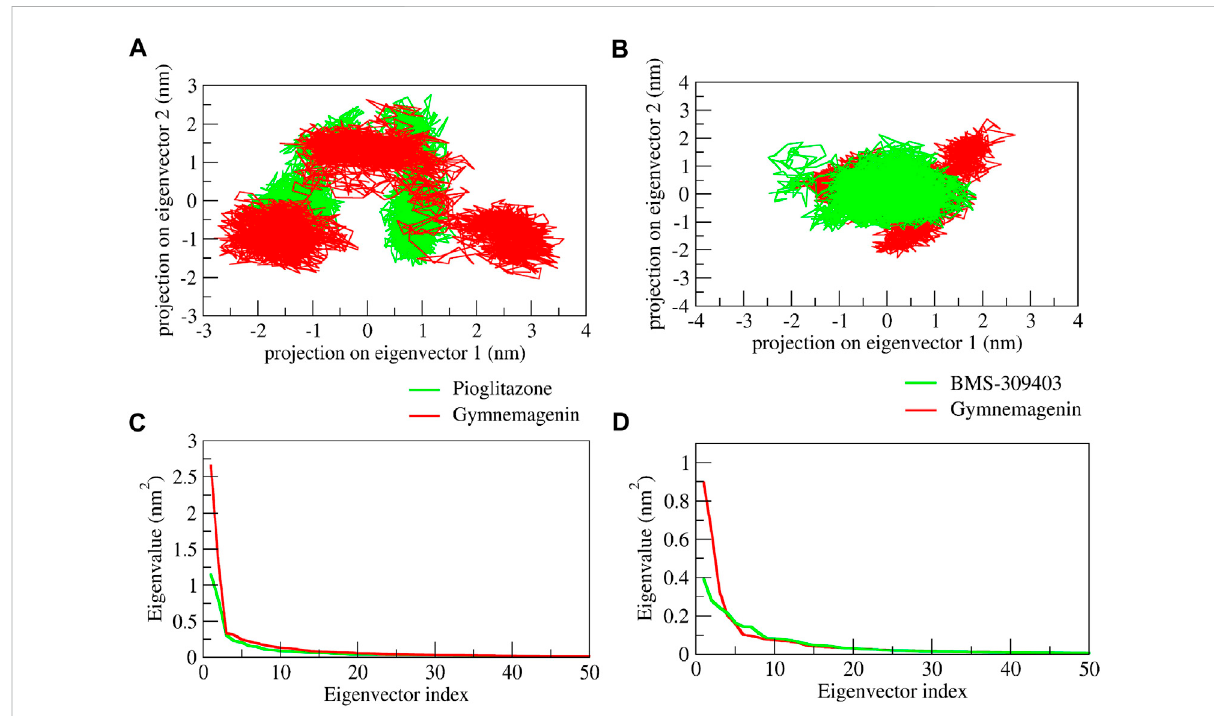
FIGURE 12 Principal component analysis of protein-ligand complexes: the collective motion of gymnemagenin (red) and standard (green) with (A) Pparg and (B) Fabp4 using projections of MD trajectories on two eigenvectors corresponding to the fi rst two principal components. The fi rst 50 eigenvectors were plotted versus the eigenvalue for gymnemagenin (red) and standard (green) with (C) Pparg and (D)